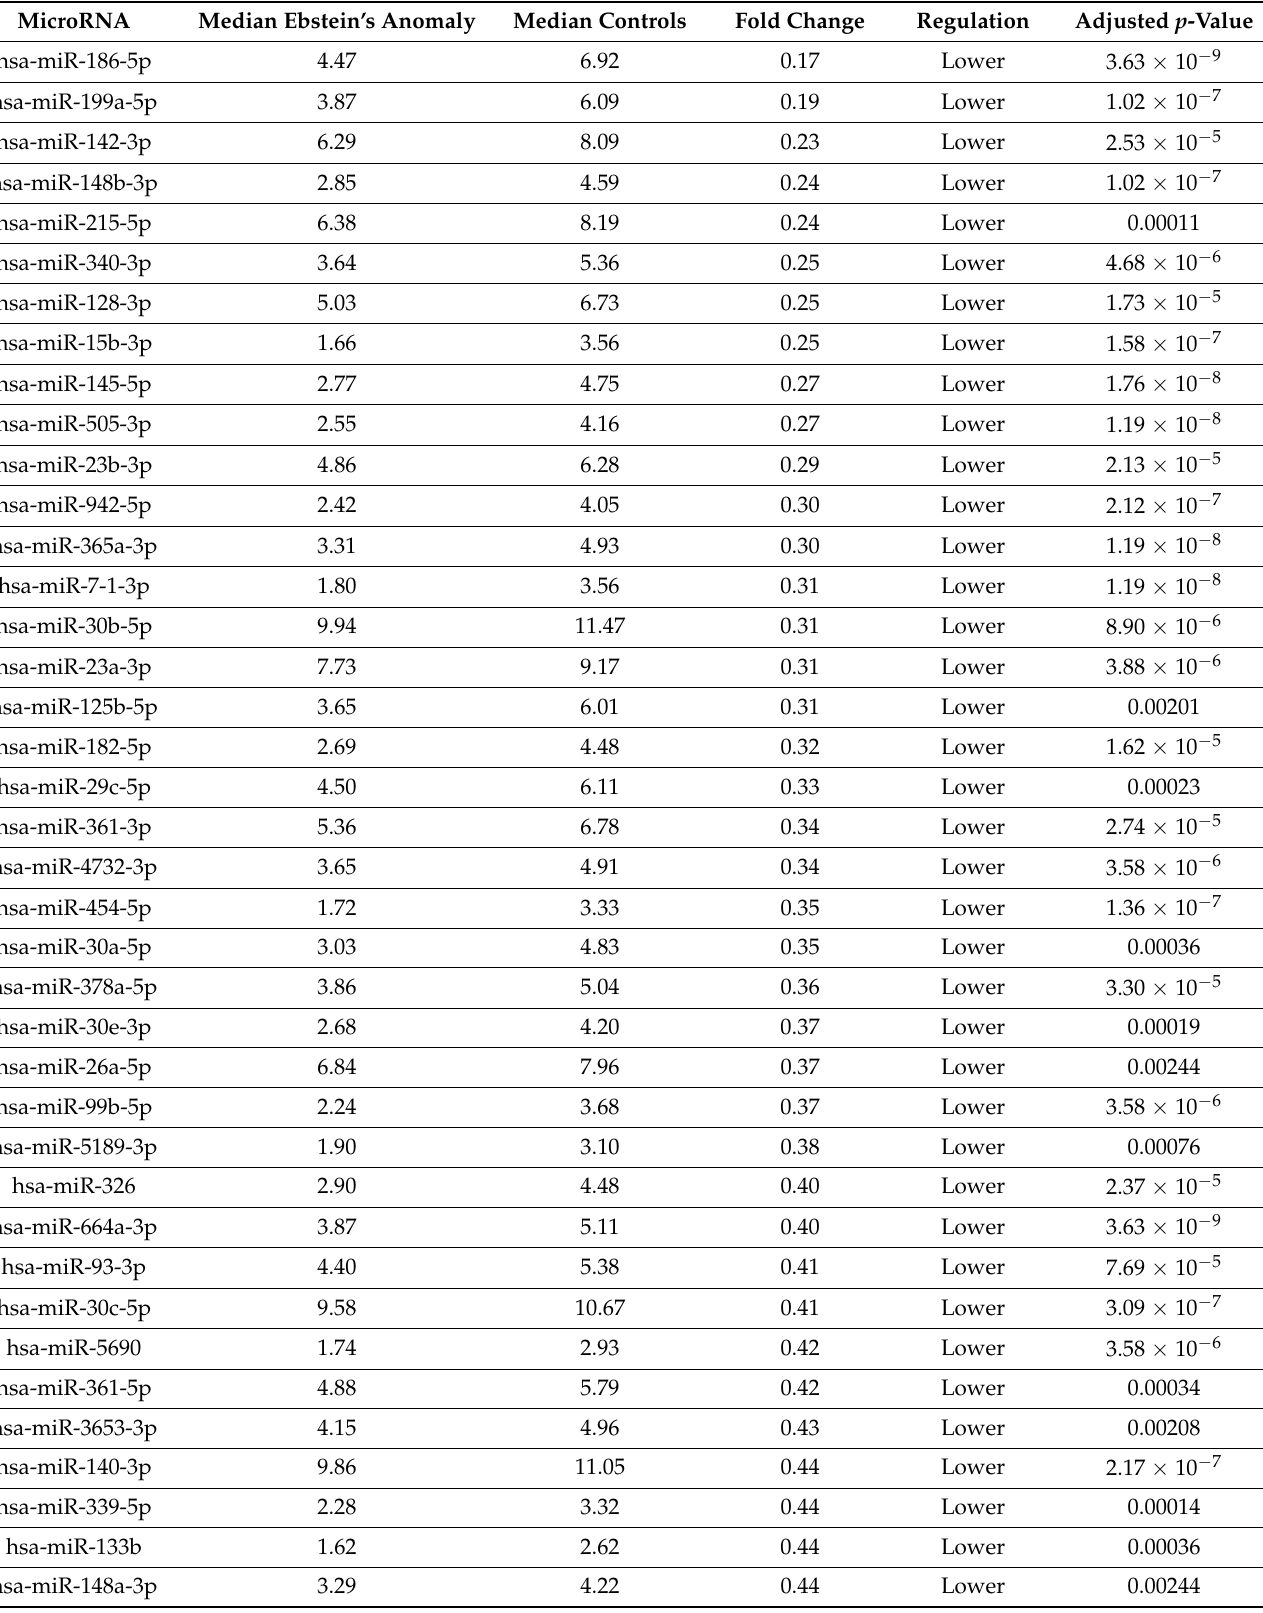
Table 1. Significantly abundant miRNAs in the blood of patients with Ebstein’s anomaly compared to healthy controls as determined by